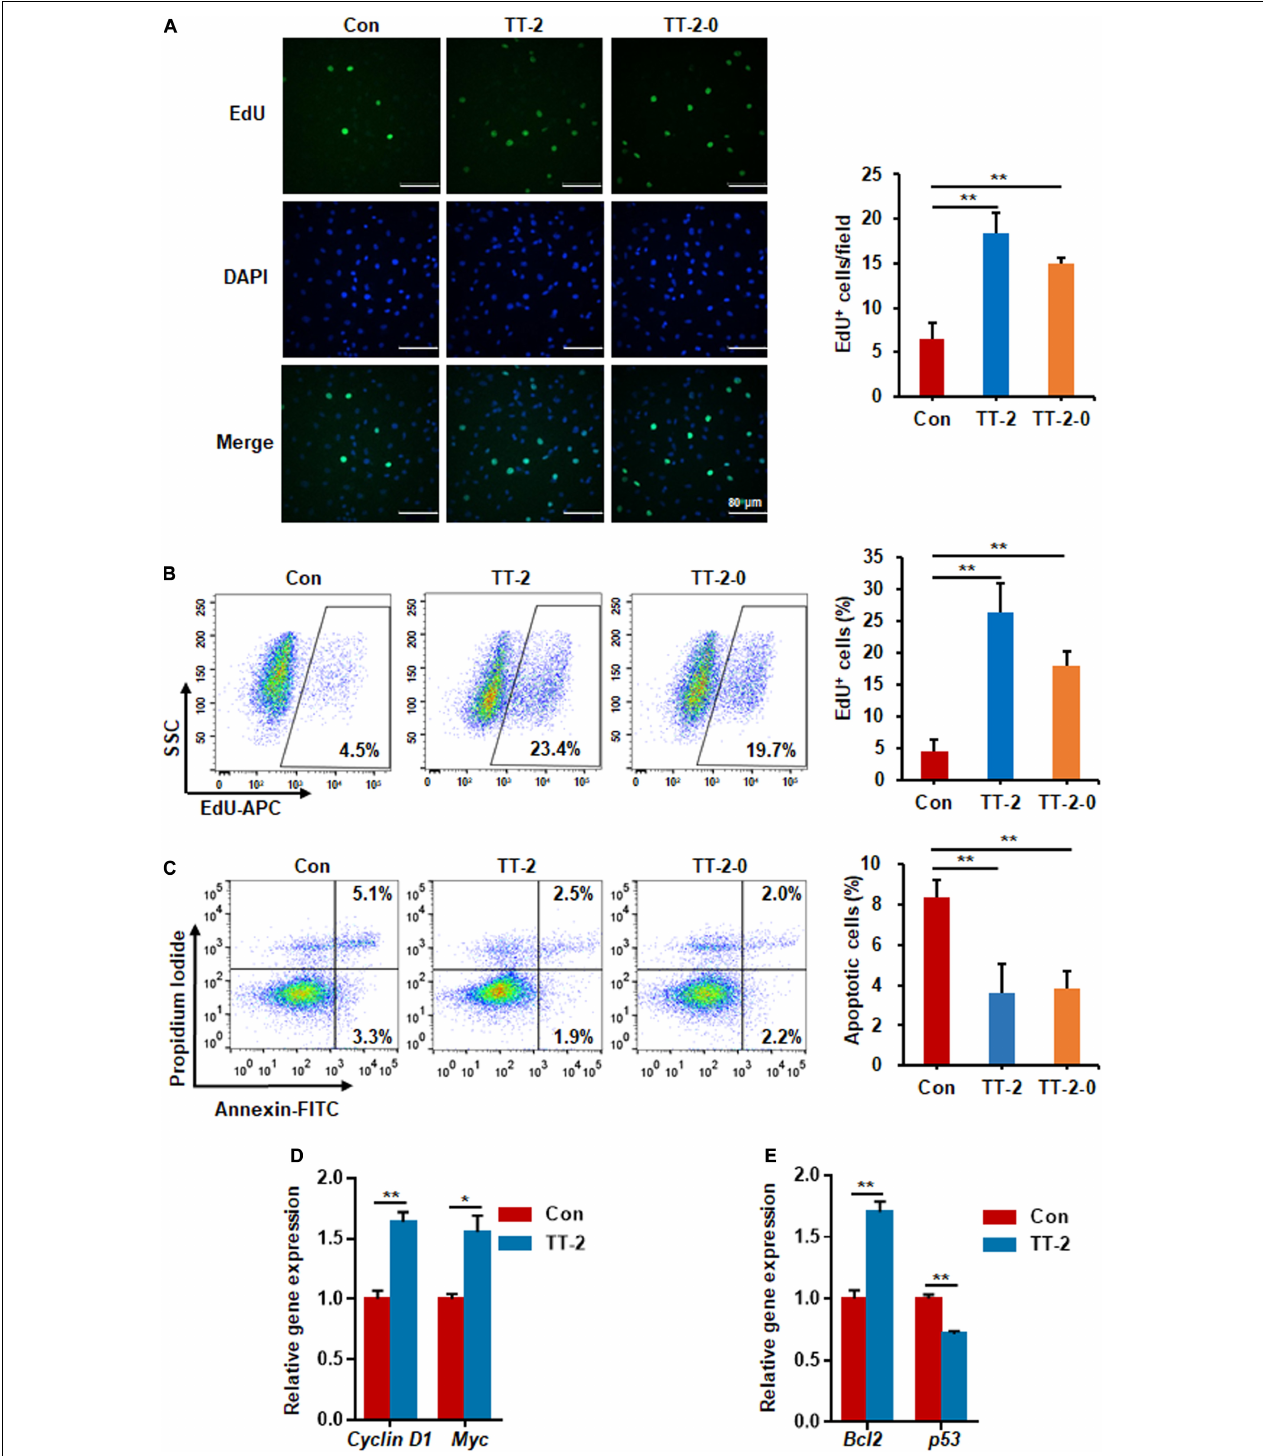
FIGURE 2 | Active fraction of Trillium tschonoskii (TT) promoted proliferation and inhibited apoptosis of IEC-6 cells after irradiation. (A) Immunostaining analysis of EdU in IEC-6 cells after irradiation with or without TT-2 or TT-2-0 for 48 h (** p < 0.01, scale bar = 80 µ m). (B) Percentage analysis of EdU incorporation for 4 h in IEC-6 cells after 10 Gy irradiation with or without TT-2 or TT-2-0 (** p < 0.01). (C) Percentage of apoptotic cells among IEC-6 cells after 10 Gy irradiation with or without TT-2 or TT-2-0 treatment for 48 h (** p < 0.01). (D) qPCR for proliferation-related gene expression in IEC-6 cells after 10 Gy irradiation with or without TT-2 treatment for 48 h (* p < 0.05, ** p < 0.01). (E) qPCR for apoptosis-related gene expression in IEC-6 cells after 10 Gy irradiation with or without TT-2 treatment for 48 h (* p < 0.05, ** p < 0.01).